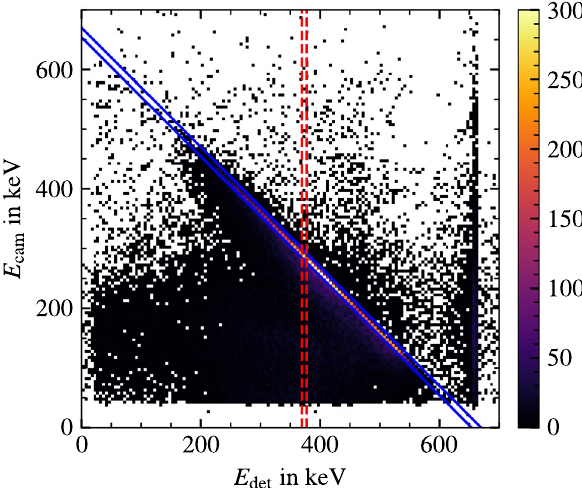
Fig. 10 Distribution of energies measured in the core of the segBEGe detector, E det , and in the pixelated camera, E cam , for coincident events during a 10min Compton Scanner measurement on the (cid:4) 100 (cid:5) axis in segment 1 at r = 33 . 5mm. Both axes are divided into bins of 5keV. The solid lines indicate the region containing events with a sum energy of E det + E cam = ( 662 ± 8 ) keV. The dashed lines indicate the energy range E det = ( 373 ± 4 ) keV,correspondingtoperpendicularlyscattered